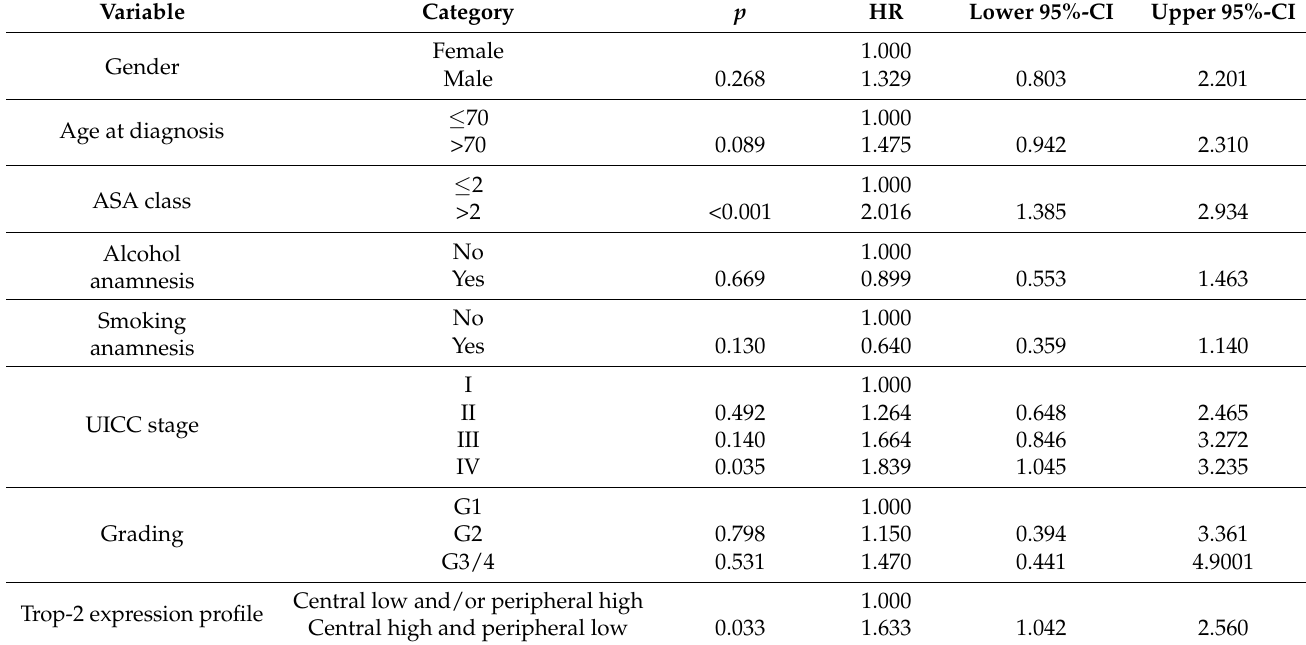
Table 3. Multivariate Cox regression for Trop-2 central high and peripheral low as well as prognostic factors on RFS, ( n = 160), UICC 7th edition.